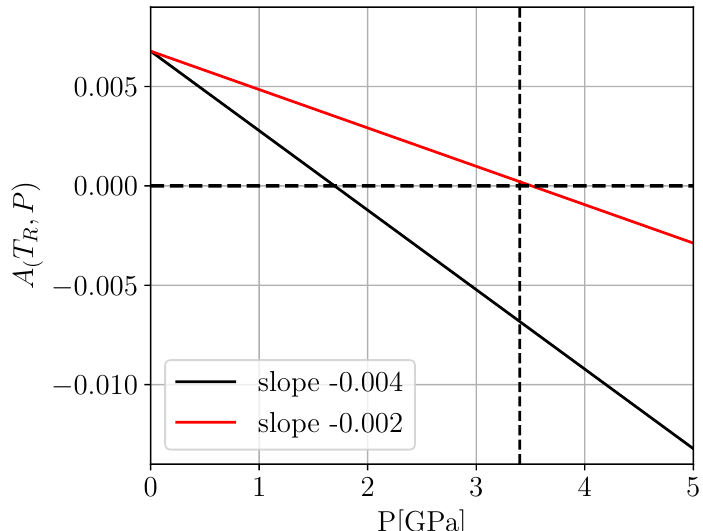
( 0 ) ( 0 ) = − 0.004 in comparison a / K